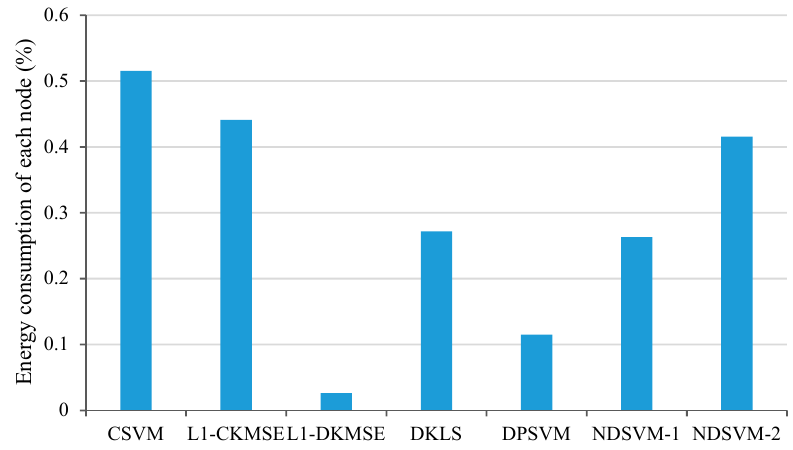
Figure 3. Comparison of the energy consumption on each node for the CSVM, L1-CKMSE, L1-DKMSE, DKLS, DPSVM and NDSVM algorithms on the test platform.